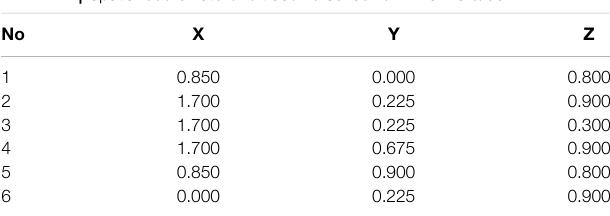
TABLE 1 | Spatial coordinate of ultrasonic sensor of